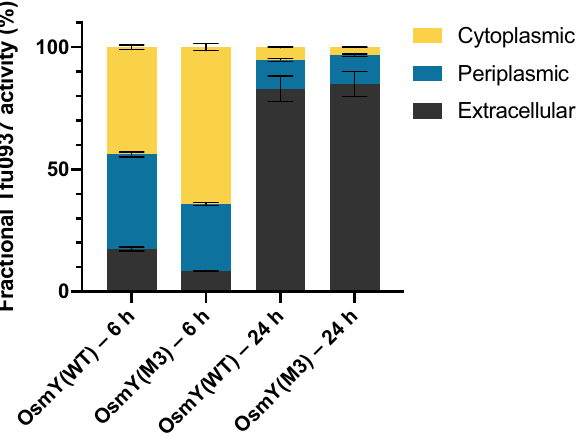
Figure 6. Fractional OsmY-Tfu0937 activity in the extracellular, periplasmic and cytoplasmic fractions of cells expressing Tfu0937 fused to either OsmY(WT) or OsmY(M3). Activity was measured with the pNPG assay using an absorbance at 405 nm. Experiments were performed in triplicate. Cells were cultivated in 2 × TY auto-induction medium at 37 °C for either 6 h or 24 h. The enzyme activity in each fraction was calculated as a percentage of total activity in all three fractions.